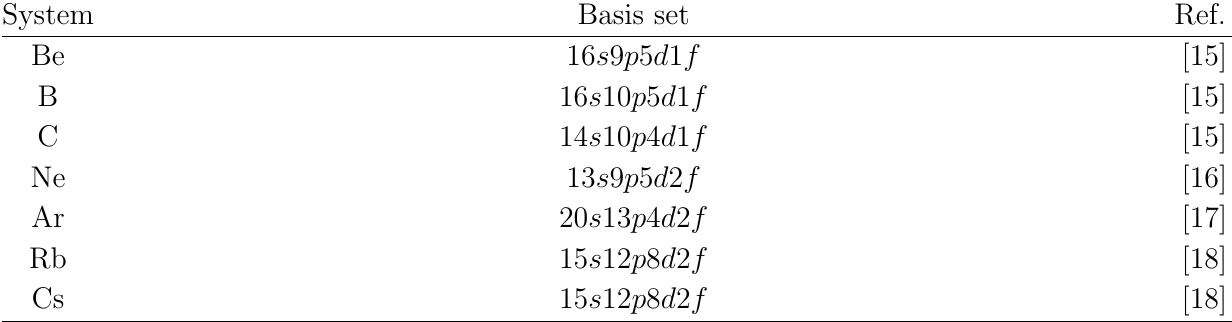
Table 1: Basis set used in the computation IPs and